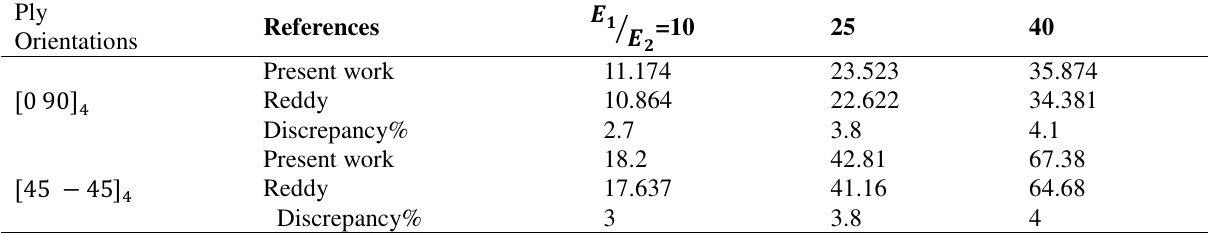
Non-dimensional buckling load , for anti-symmetric laminated plates (SSSS) with effect of different modulus ratio, (